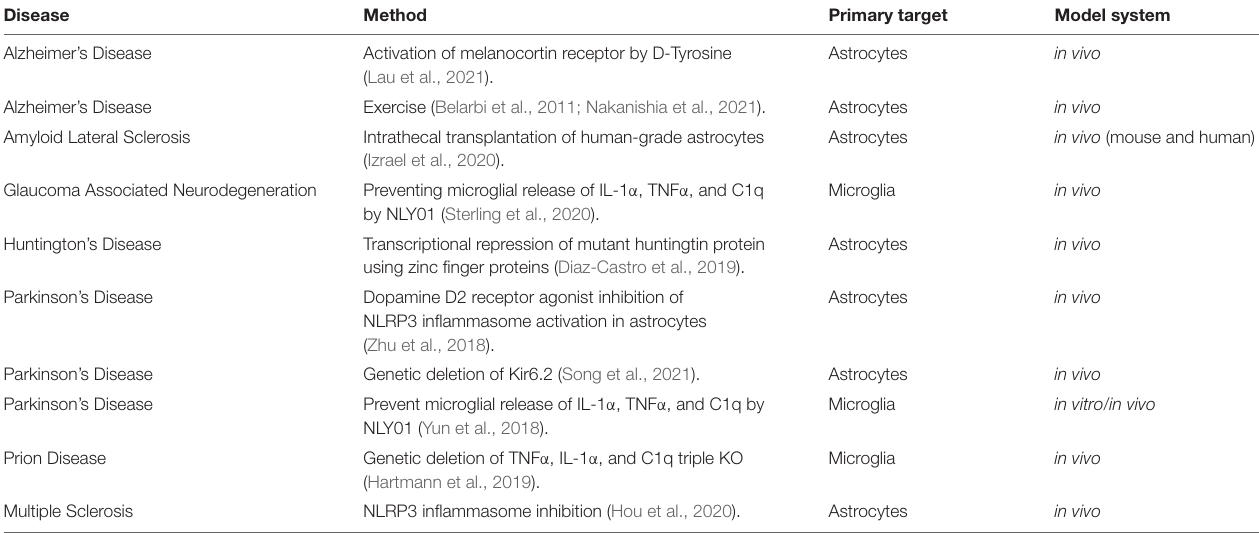
TABLE 2 | Therapeutic and mechanistic methods of targeting inflammatory astrocytes.